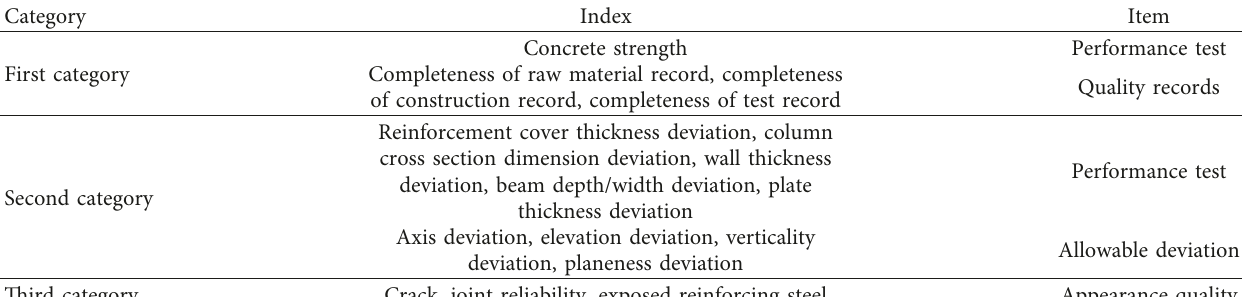
Table 2: Classification of construction quality evaluation indicators.